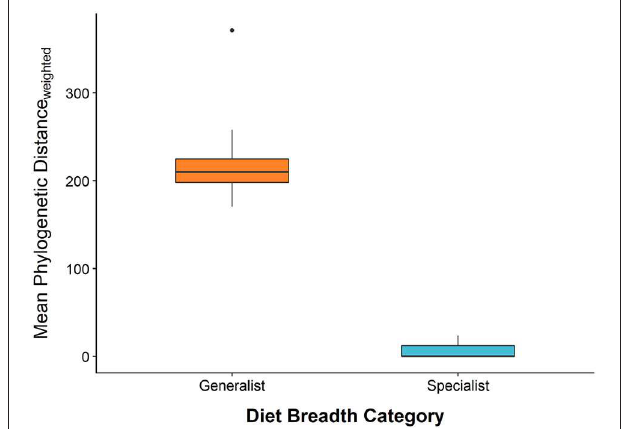
FIGURE 2 | A comparison of each caterpillar species’ continuous measure of diet breadth (mean phylogenetic distance among hostplant species) and categorically defined specialist and generalist subsets of the caterpillar community. Horizontal bars represent the median, box edges represent the 1st and 3rd interquartile range, whisker tips represent the minimum and maximum, and points are outliers. Outliers represent caterpillar species with small sample